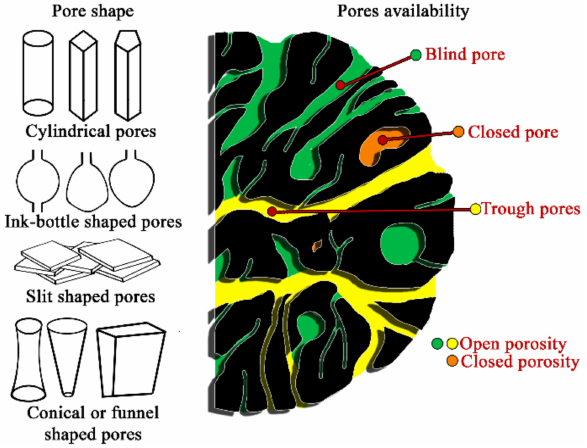
Figure 1. Scheme of pores classifications, according to pores geometrical shape and availability. Table 1. Classifications of pores based on pores width and functions.